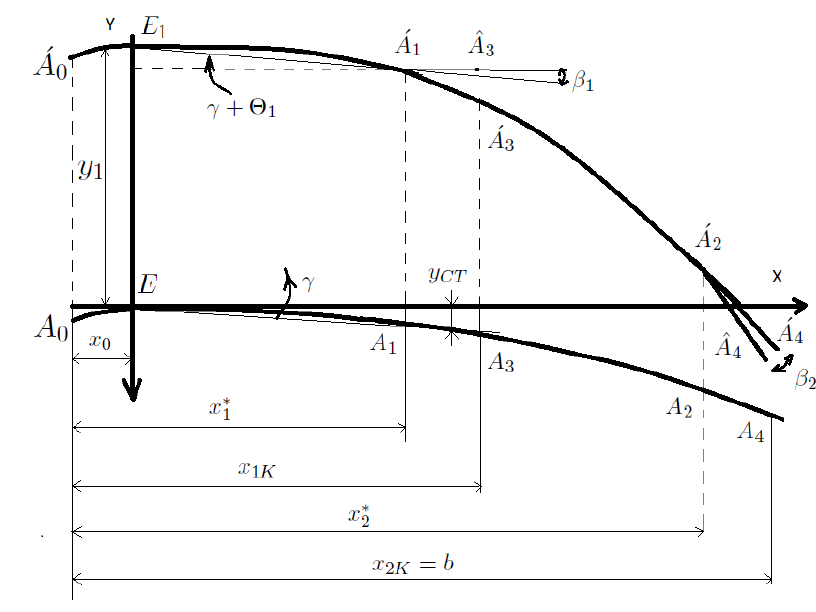
Figure 4. Wing profiles in a static position and during vibrations. Parameters Θ 1 , wing deflection y CT are ordinates in a static position, β i are consid- ered